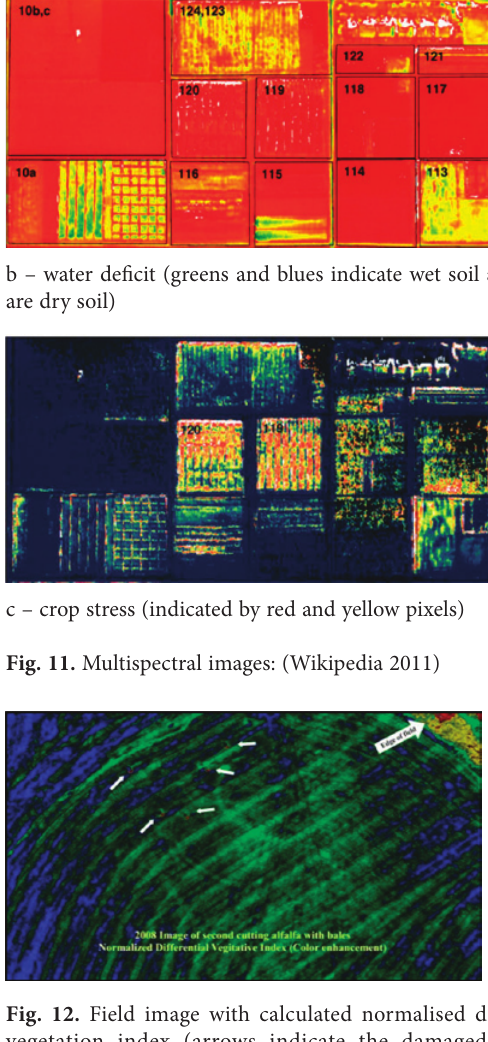
Fig. 12. Field image with calculated normalised difference vegetation index (arrows indicate the damaged plants) (Honeycutt